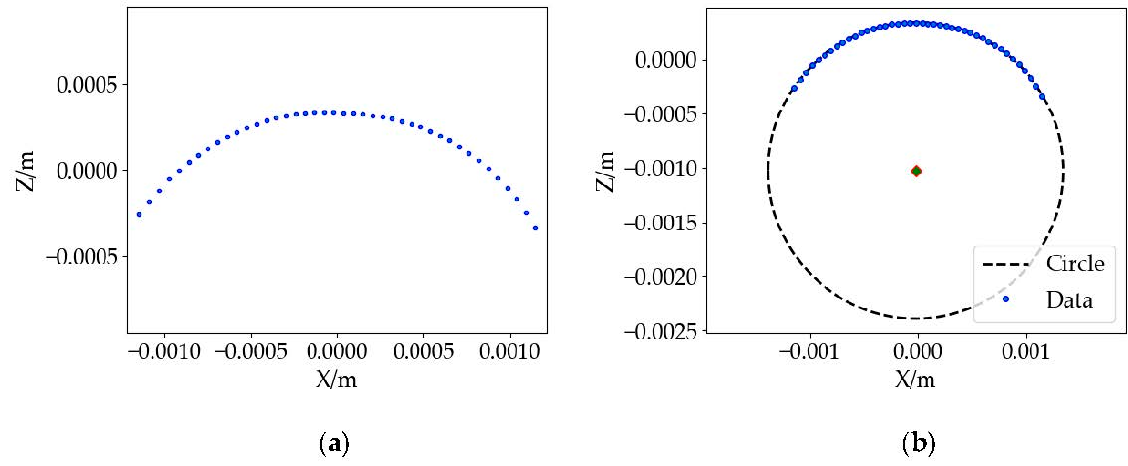
Figure 11. Tooth surface arc fitting: ( a ) contour point cloud projection, and ( b ) schematic diagram of least squares fitting circle.